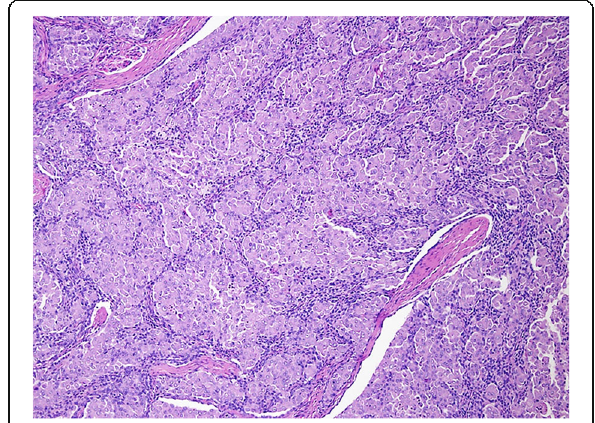
Fig. 7 Biphasic squamoid alveolar RCC consisting of nests and sheets of squamoid cells with pale cytoplasm surrounded by smaller basophilic cells with scanty cytoplasm